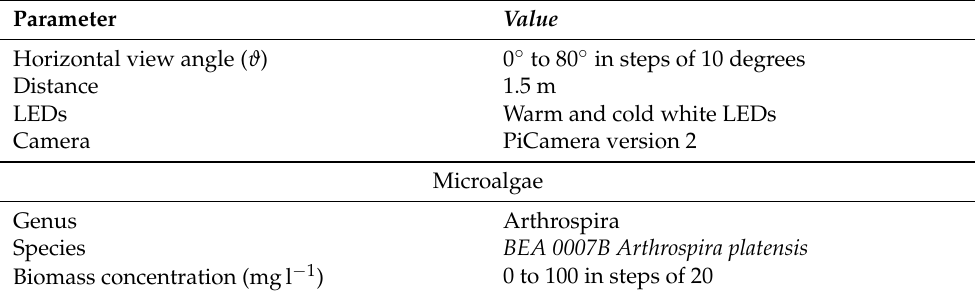
Table 2. Indoor experiment key parameters.